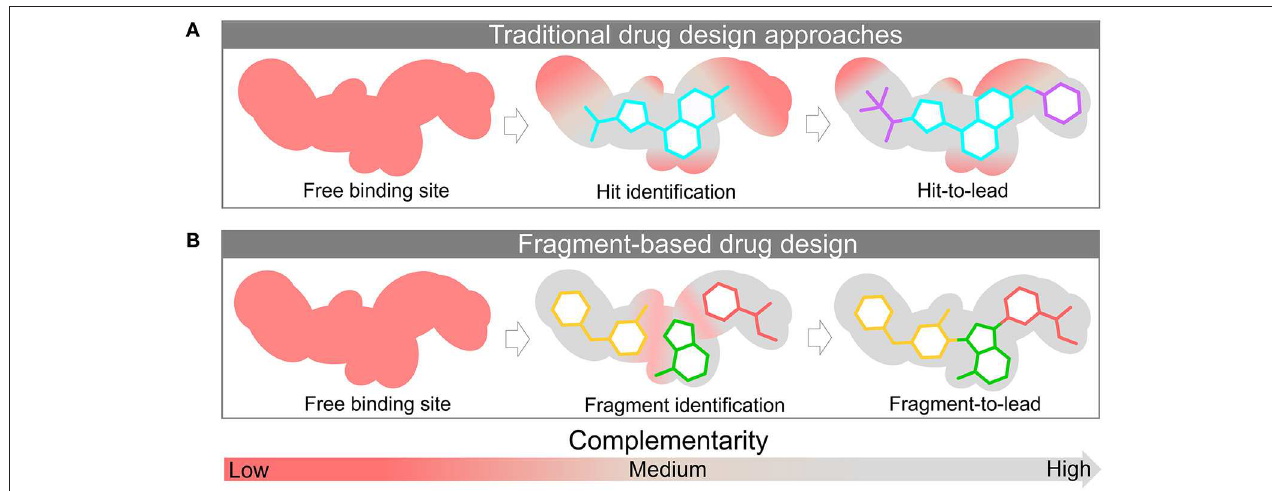
FIGURE 2 | Discovery and structural-optimization of drug-like molecules (A) and fragments (B) using protein target information. The surface represents the binding site. The red and gray colors represent the level of complementarity of ligand with the active site. Pockets with low complementarity with ligand are colored in red; pockets with high complementarity with ligand are highlighted in